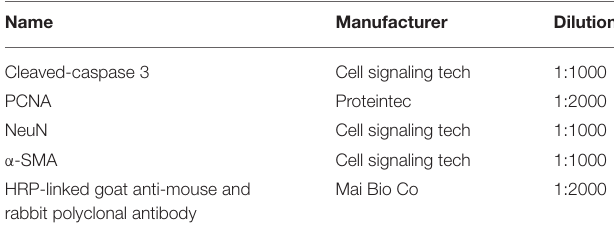
TABLE 1 | Antibodies used for western